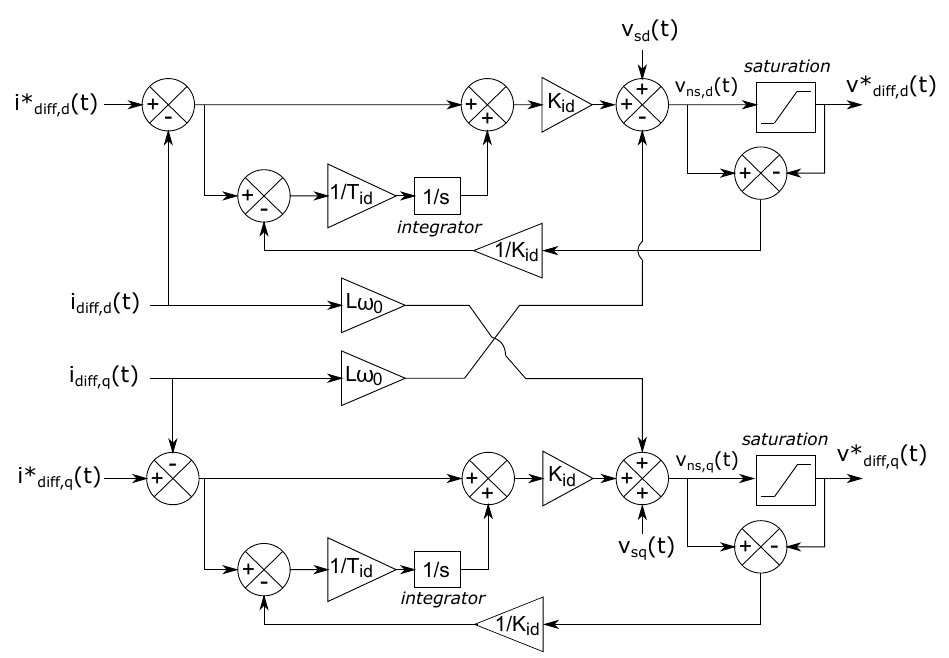
Figure 7. Block diagram of the output-current controller. “Direct voltage control” (DVC), this strategy provides asymptotic stability of the arm- energies [30,31] while however introducing circulating currents in the converter, because the total capacitor voltage has a ripple at both grid-frequency f 0 and twice grid-frequency. Thus, a circulating current suppression controller (CCSC) is implemented [32], as shown in Figure 8. As the second-order harmonic is the most significant, only this harmonic is suppressed. The first unwanted harmonic appears at four times the grid frequency, but its influence is barely visible from a distortion point of view. The approach proposed output-current controller operates along the “diff” components, in the dq0 plane, whereas